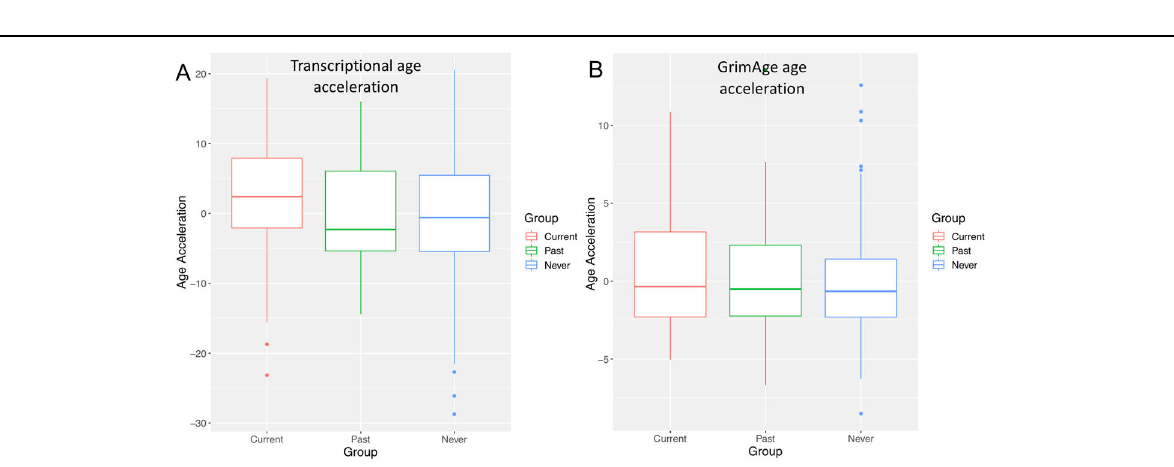
Fig. 2 Age acceleration versus PTSD diagnosis. A Box plot comparing transcriptional age acceleration to PTSD diagnosis. B Box plot comparing GrimAge age acceleration to PTSD diagnosis.